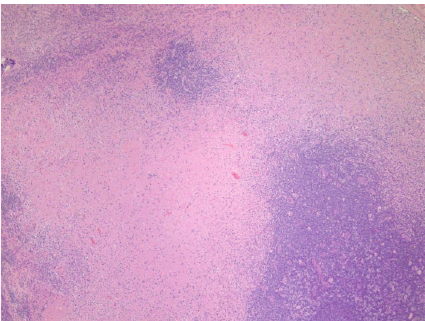
F 2: Cervical Lymph node disrupted architecture on Hema- toxylin and Eosin (H�E) stain at 40� magni�cation.